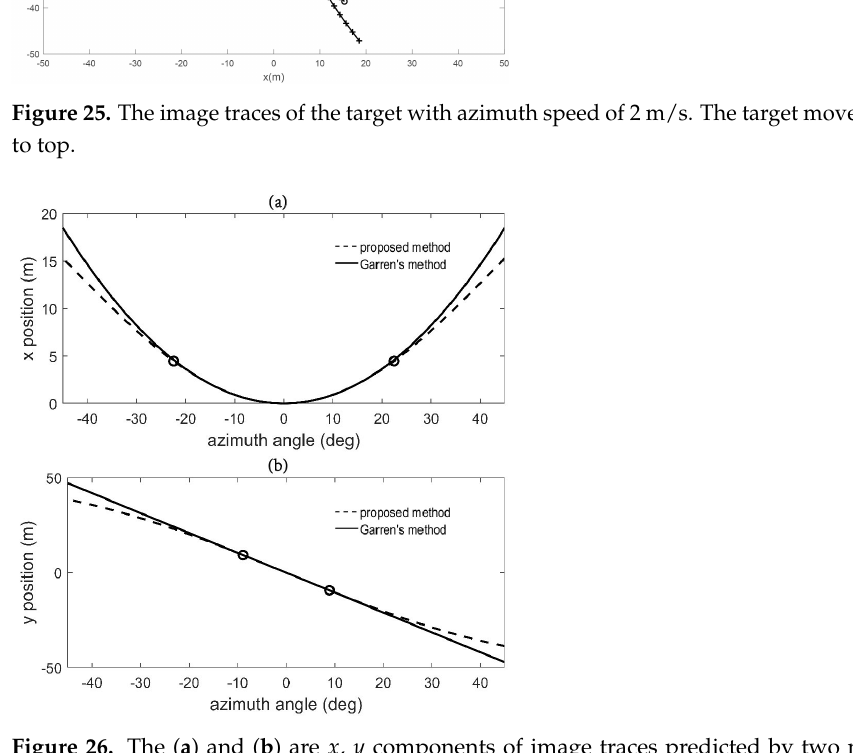
Figure 26. The ( a ) and ( b ) are x , y components of image traces predicted by two models versus azimuth viewing angle